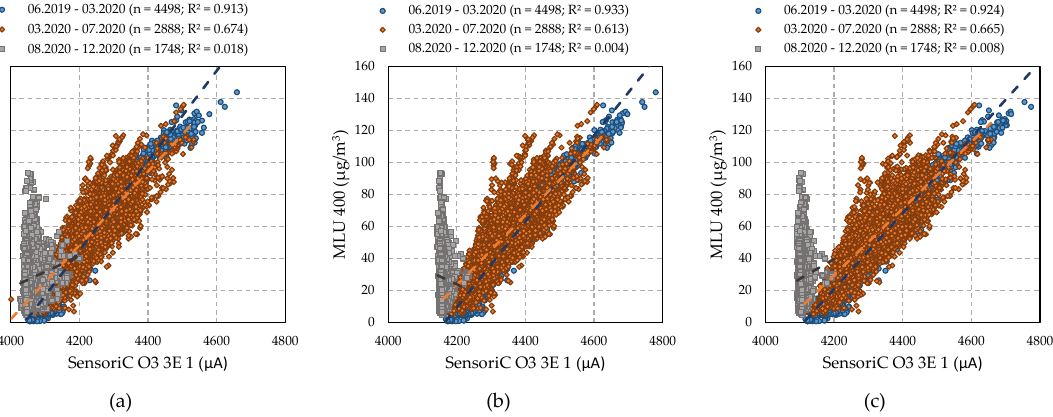
Figure 3. Results of linear fittings for 1-h averaged data from SensoriC O3 3E 1: ( a ) unit No. 1; ( b ) unit No. 2; ( c ) unit No. 3. Dashed lines denote the fitted curves. n—number of samples used for the fitting, R 2 —coefficient of determination.